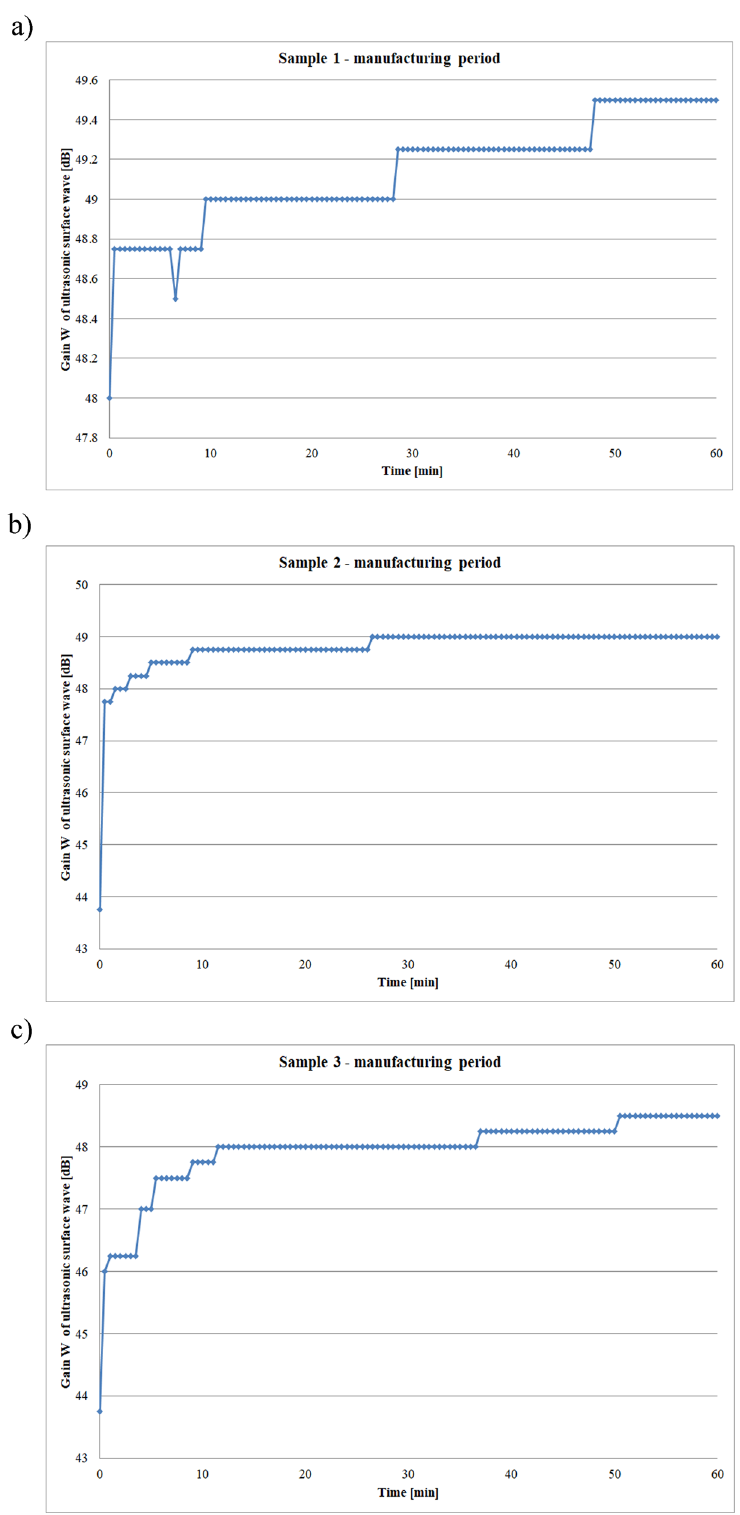
Figure 6: Course of ultrasonic wave gain during the process of constitution of the coating – substrate interface – the period of the fi rst 60 min after application of the coating to the steel substrate: ( a ) sample 1, ( b ) sample 2 and ( c ) sample